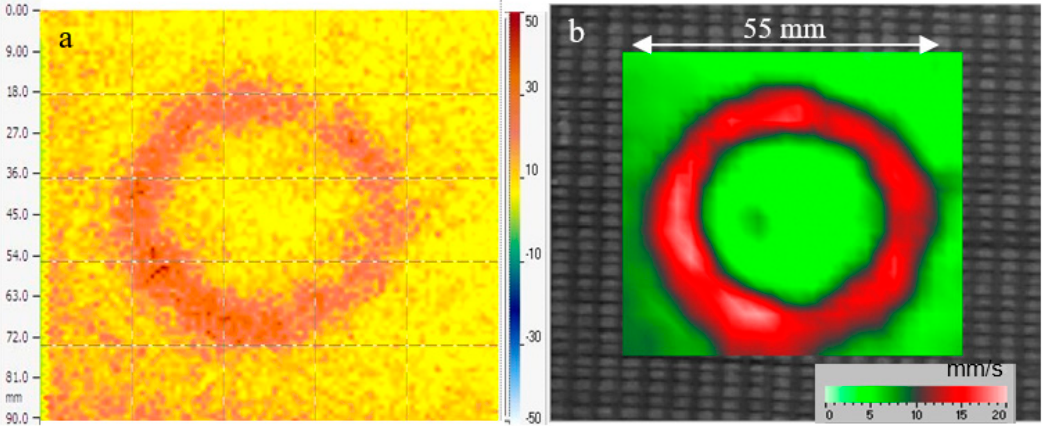
Figure 17. ( a ) robotic AE image of a ring delamination in CFRP; ( b ) wideband laser vibrometry image.